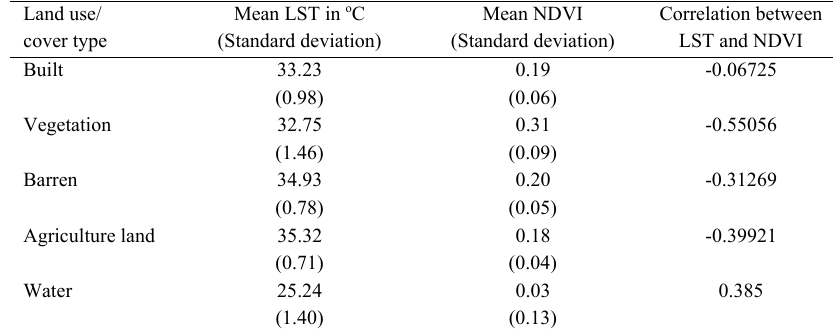
Table 2: Descriptive band statistics of LST and NDVI across Land Use/Cover type